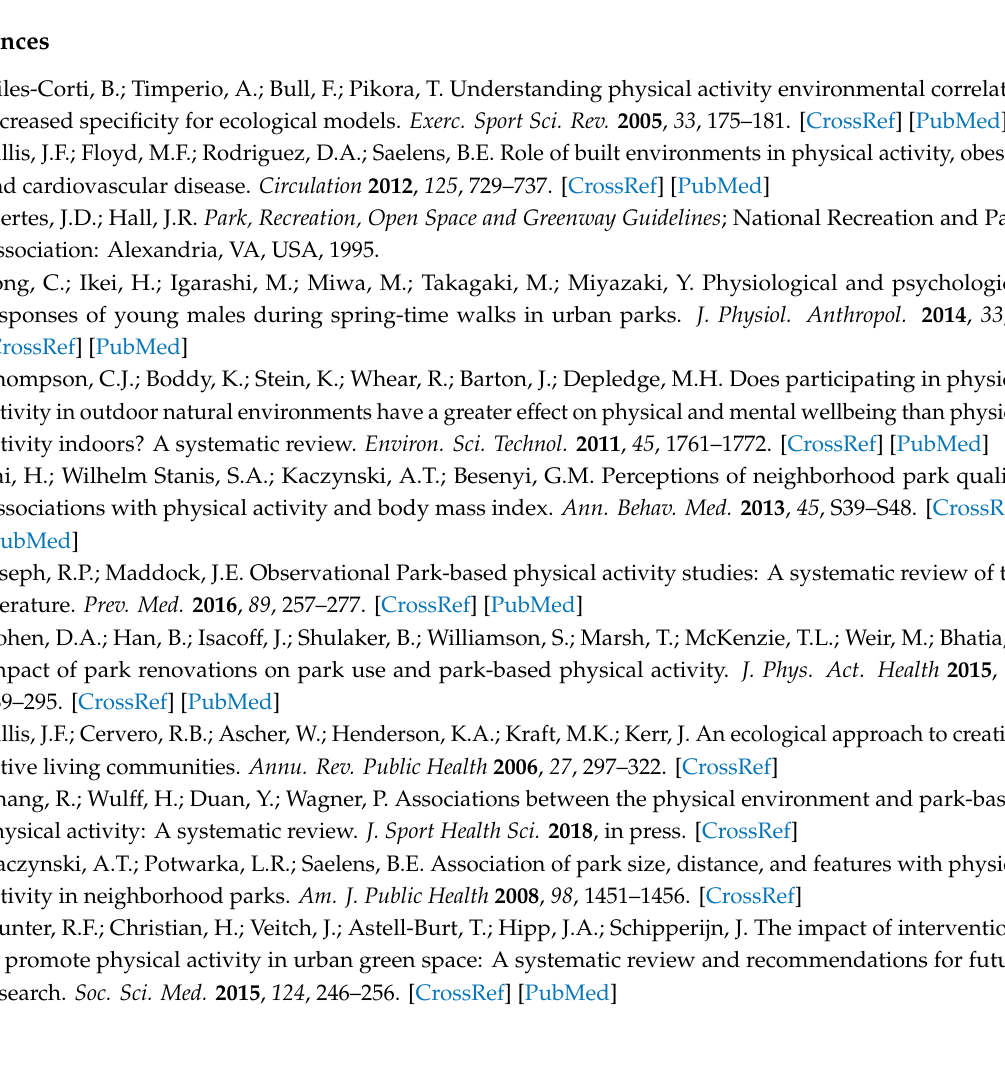
Table S1: Urban park environment in Hong Kong and Leipzig; Table S2: Constructs and description used in the observation analyses; Table S3: Measures used to assess the perceived park environment, psychosocial factors and park-based physical